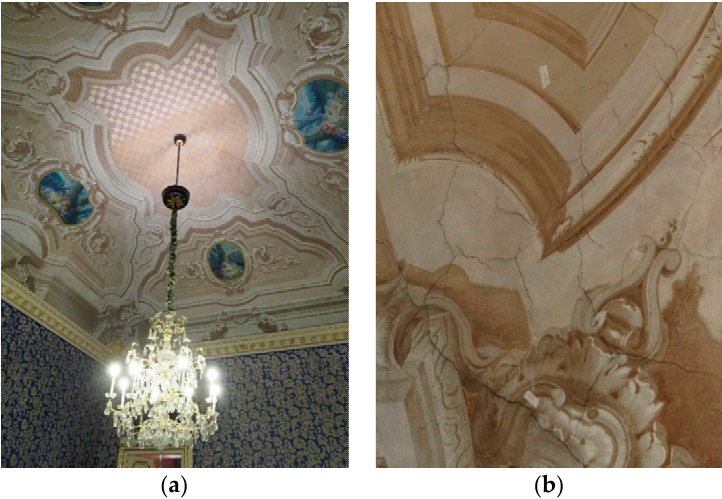
Figure 2. ( a ) Blu room at Birago Palace; ( b ) cracks branched in the decorated plaster of the masonry vault in the Blu room.